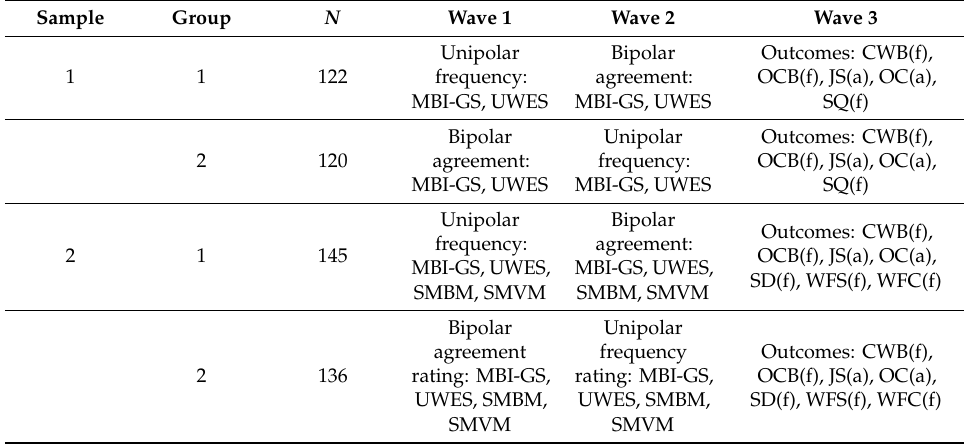
Table 1. Measures delivered in di ff erent waves among two